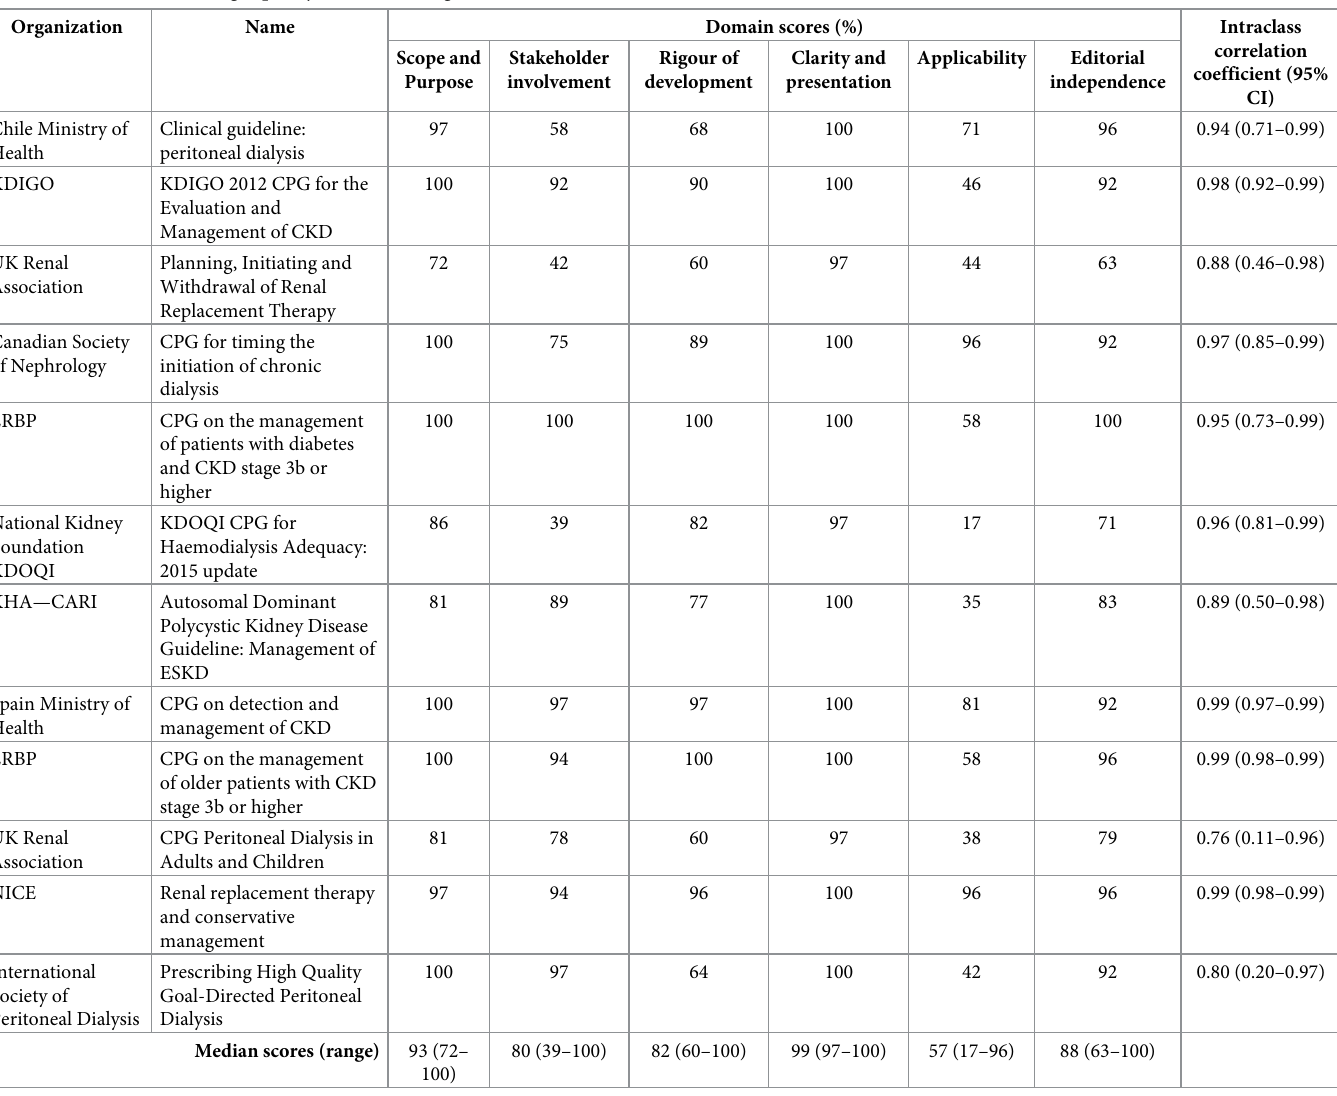
Table 3. Domain scores of high-quality CPGs according to the AGREE II